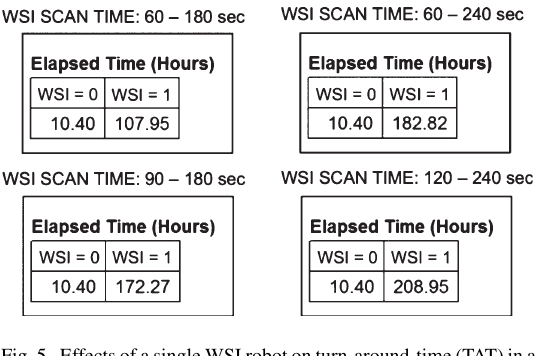
Fig. 5. Effects of a single WSI robot on turn-around-time (TAT) in a high-volume(2400slides/day)clinicalhistologylaboratory.Thetop rows in the above charts represent the process model used (baseline histology model: WSI=0, WSI robot process model: WSI=1). The bottom rows in the above charts represent the TAT (hours) needed to complete the simulation for each model.